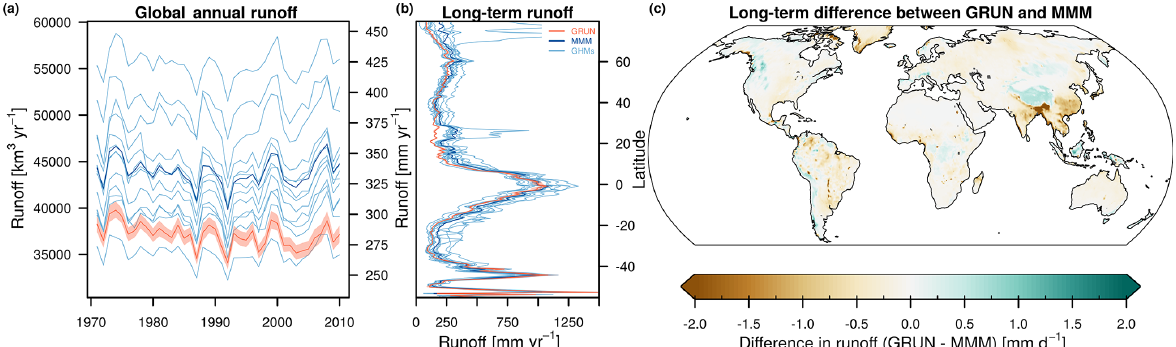
Figure 8. The uncertainty of GRUN, attributed to the finite sample of training data, compared to the spread introduced by different physical representations of the hydrological processes in the ISIMIP2a GHMs. The shaded area around GRUN lines shows the entire distribution of the 50 GRUN simulations. (a) Global annual runoff. (b) Latitudinal average of long-term mean runoff. (c) Difference between GRUN and the MMM long-term mean runoff. Grey cells represent missing values caused by missing data in some of the ISIMIP2a GHM simulations.